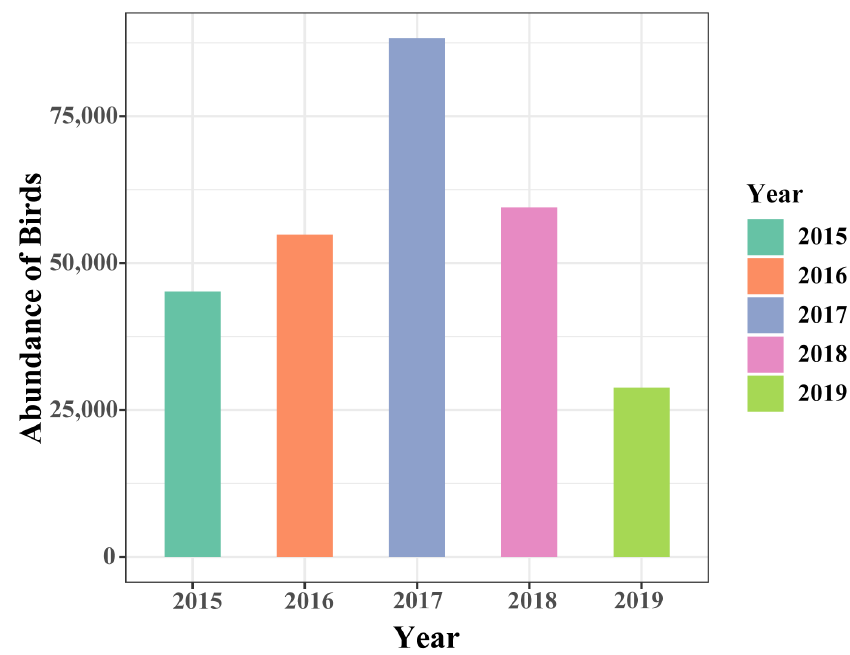
Figure 5. Total abundance of birds counted annually.